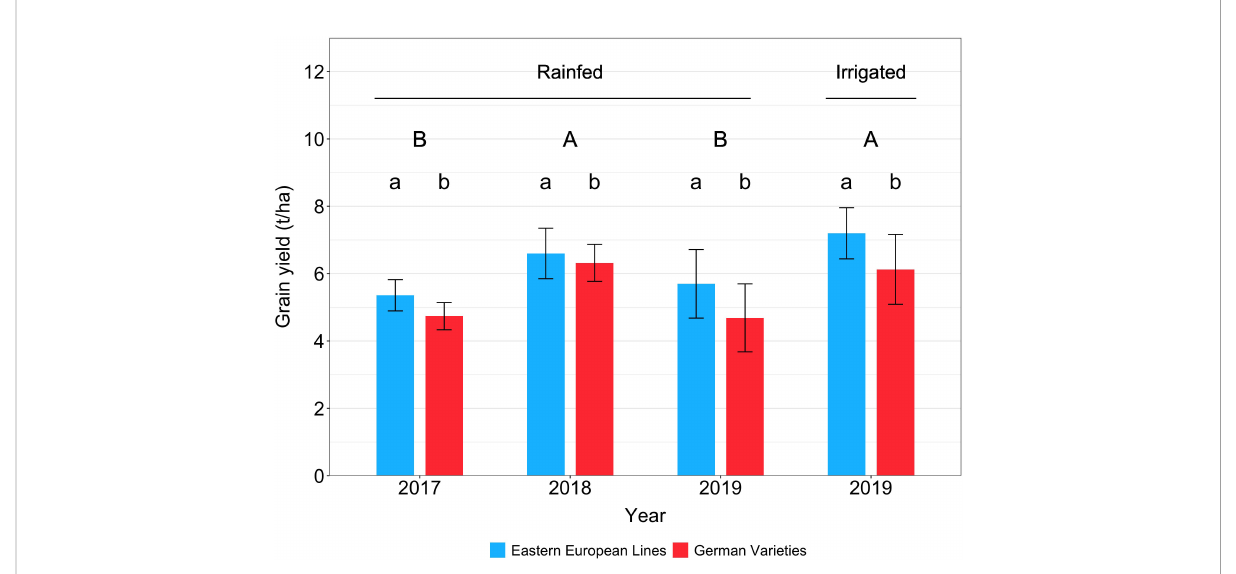
FIGURE 3 Wheat grain yield of Eastern European lines and German varieties under rainfed conditions in 2017, 2018, and 2019 and under irrigated conditions in 2019. The vertical bars indicate the standard deviation of the mean. Capital letters indicate signi fi cant differences between the years, small letters indicate signi fi cant differences between origins within one